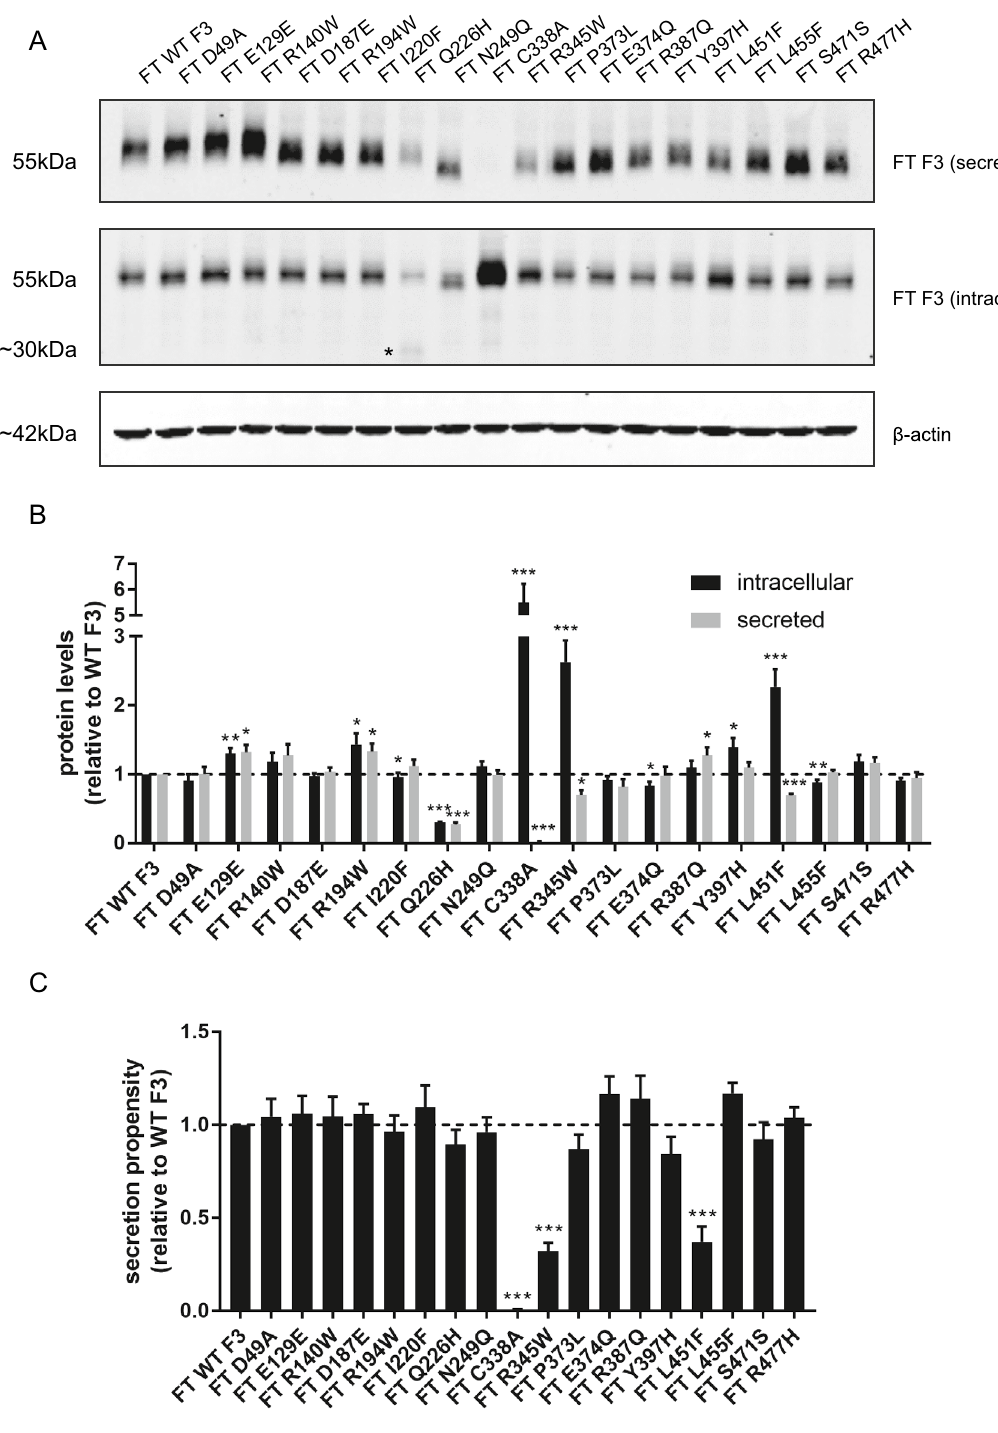
Figure 2. Secretion of F3 variants. ( A ) Western blot of secreted and intracellular levels of F3 variants in HEK293A cells. Asterisk indicates truncated intracellular Q226H band. ( B ) Quantification of secreted, intracellular, and ( C ) secretion propensities of F3 variants shown in ( A ), n ≥ 6, mean ± SEM (* p < 0.05, ** p < 0.01, *** p < 0.001, one sample t test vs. a hypothetical value of 1 [i.e.,